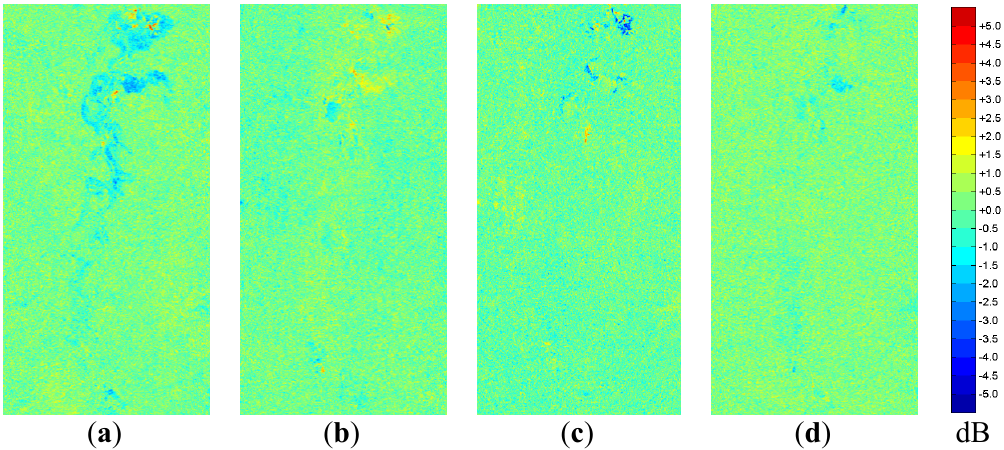
Figure 11. Change in Kennaugh Element k (parallel absorption) between sequent acquisitions 1 scaled in decibel: ( a ) April to May; ( b ) May to June; ( c ) June to July; and ( d ) July to August.